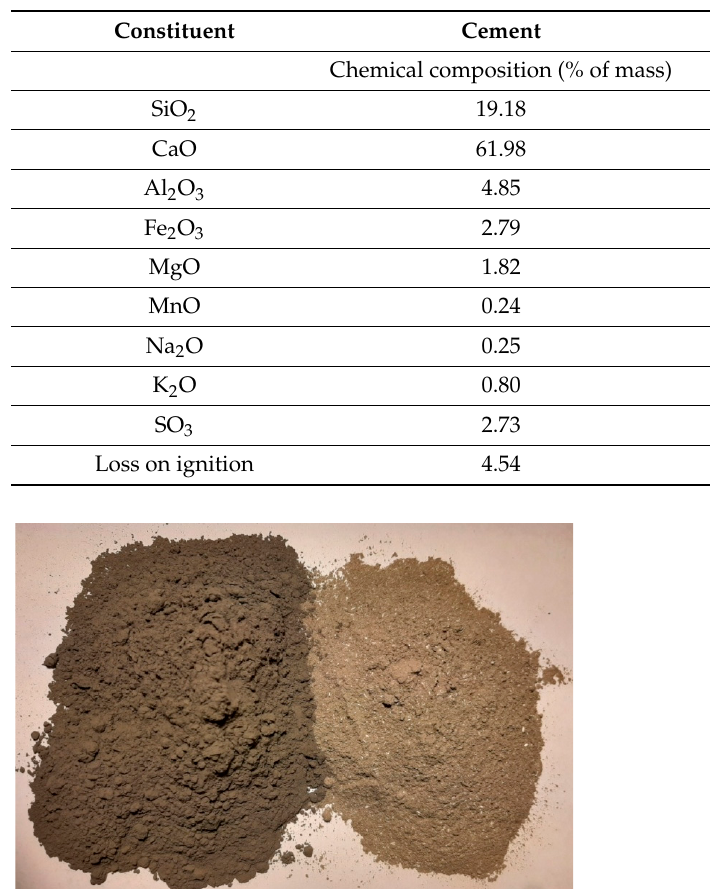
Table 1. Chemical composition of cement and crystalline waterproofing admixture (CWA).